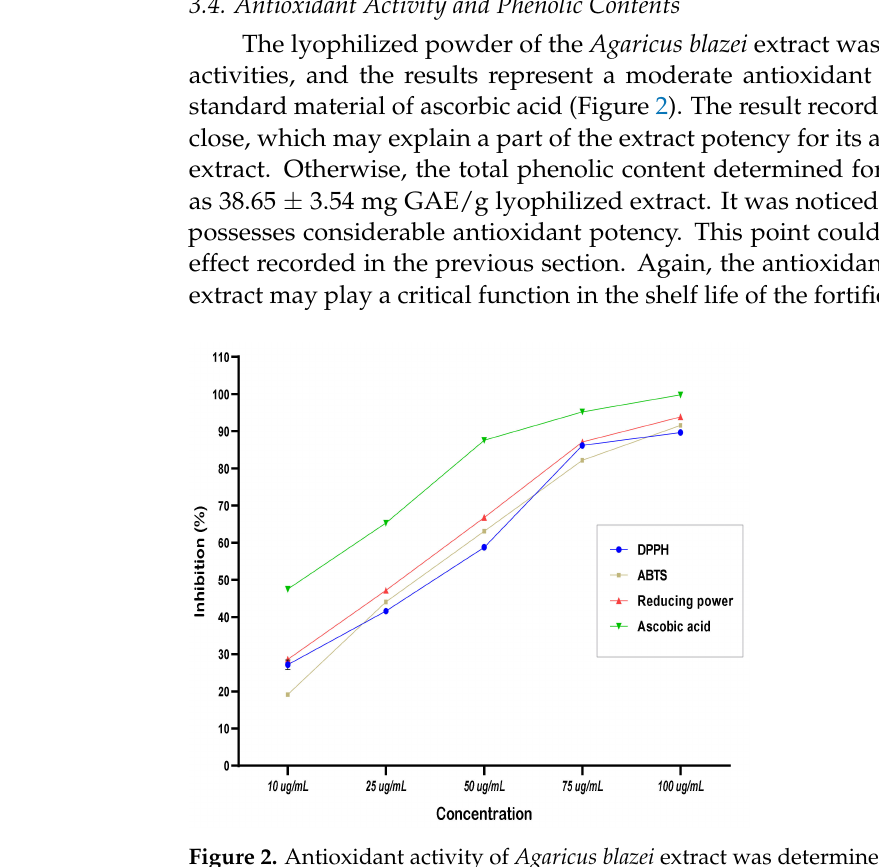
Figure 2. Antioxidant activity of Agaricus blazei extract was determined using 3 different